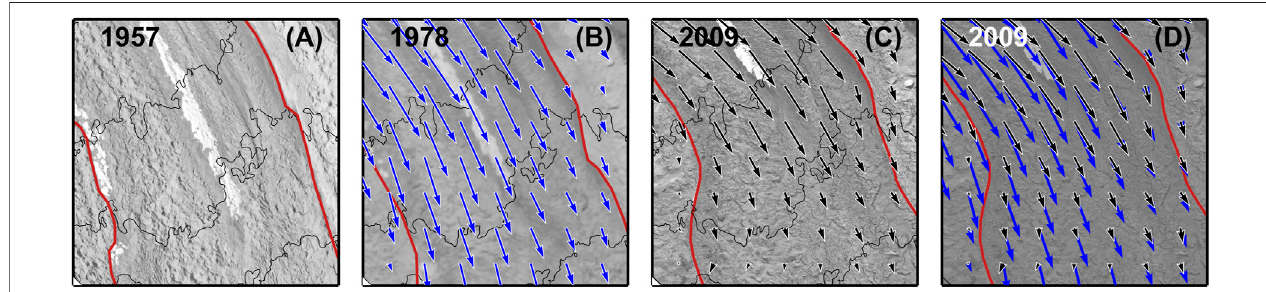
FIGURE4| Changesindebrisextent.Eachpanelre fl ectsthesame3 × 3 kmareaontheglaciersurface(see Figure6 ).Redlinesineachpanelrepresenttheborder betweenthesamemedial moraines. Note thedistinctchangeinmedial moraine boundaries through time,especiallybetween 1978and 2009. (A) 1957aerial photo. (B) 1978 aerial photo with annual surface velocity vectors from 1991. The largest vector at the top of the panel has a magnitude of 105 m yr − 1 . (C) 2009 WorldView image with annual surface velocity vectors from 2015. The largest vector at the top of the panel has a magnitude of 75 m yr − 1 . Flow is compressive where debris extent has expanded. (D) 2009 WorldView image, with darker shade, overlaid with annual surface velocity vectors from 2015, in black with white outlines, and the annual surface velocity vectors from 1991 in blue.